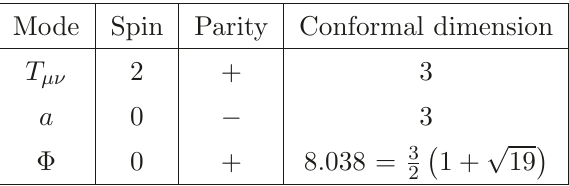
Scenario in the limit